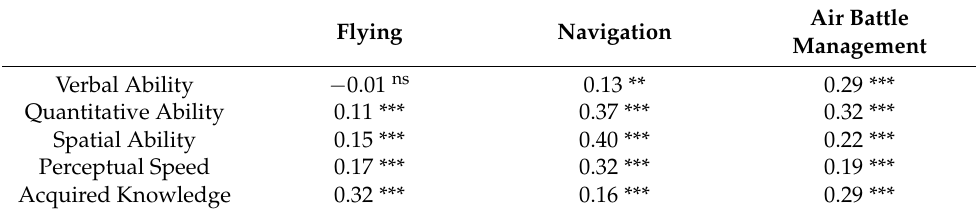
Note. Gray color indicates negative estimate or nonsignificant positive estimate ( p > 0.05). Model fit was as follows. ns, p < 0.10. ** p < 0.01. *** p <